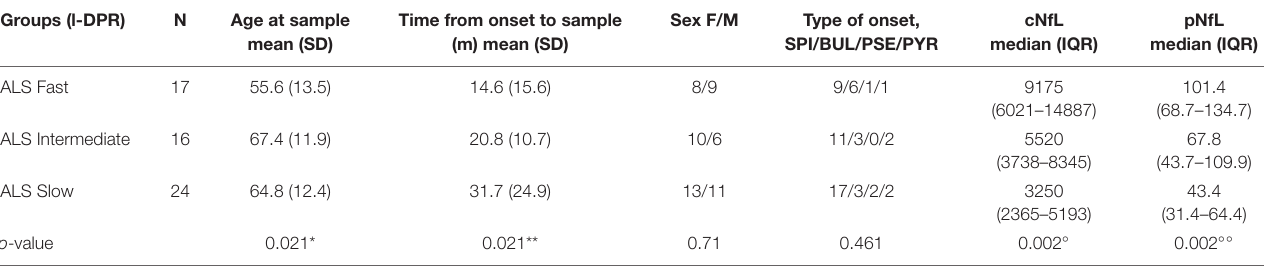
The p-values reported directly in the table refer to the multiple-groups comparison analyses. Only the p-values of the comparisons showing a statistically significant difference at the post hoc analysis are further detailed in the table legend. Biomarker values are expressed in pg/ml. Key: ALS, amyotrophic lateral sclerosis; BUL, bulbar; cNfL, cerebrospinal neurofilament light chain; F, females, l-DPR, longitudinal disease progression rate; IQR, interquartile range; m, months; M, Males; N, number; pNfL, plasma neurofilament light chain; PSE, pseudopolyneuritic; PYR, pyramidal; SPI, spinal; SD, standard